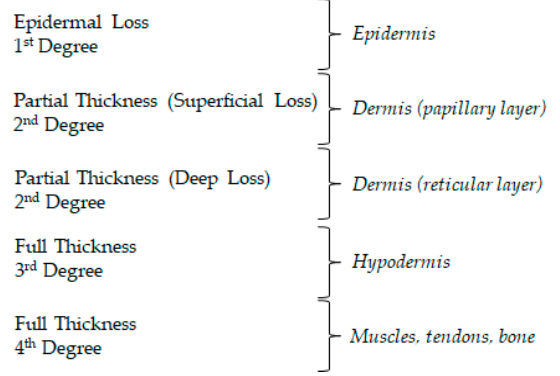
Figure 1. Different degrees of burn wounds and affected skin layers. Figure 1. Di ff erent degrees of burn wounds and a ff ected skin